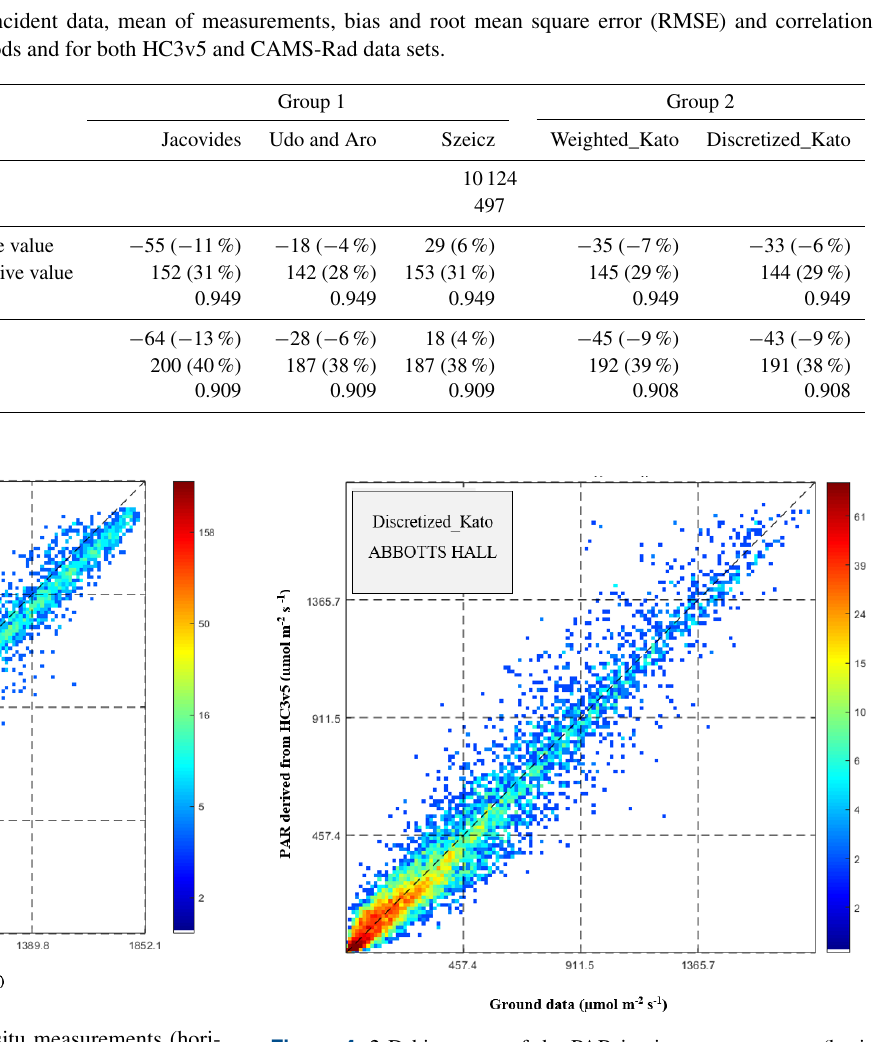
Figure 4. 2-D histogram of the PAR in-situ measurements (hori- zontal axis) and PAR derived from HC3v5 estimates using the Dis- cretized_Kato method (vertical axis) at Abbotts